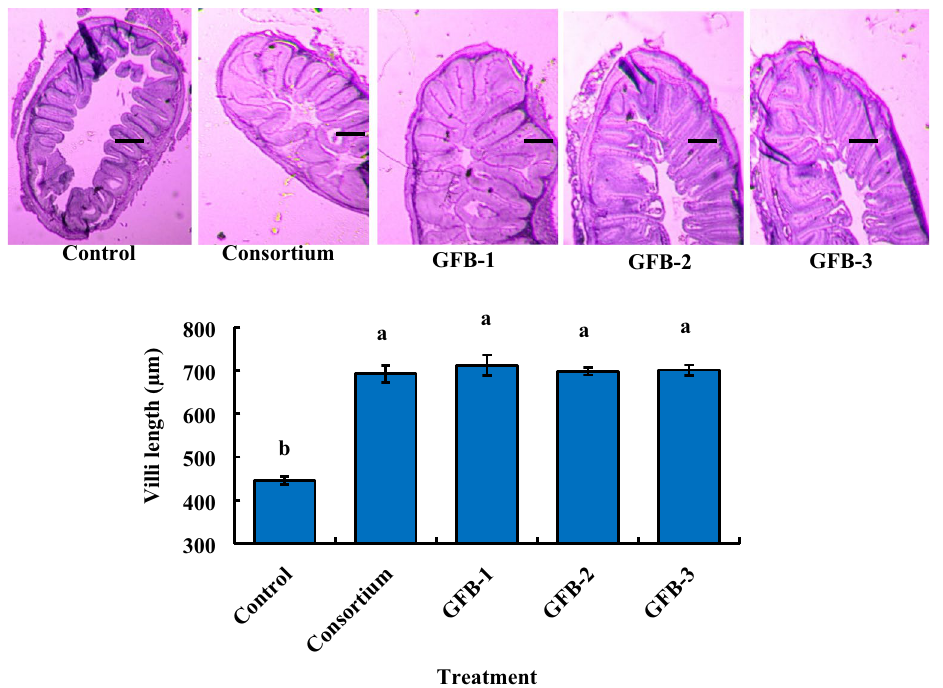
Figure 5. Histological analysis of the effects of probiotic bacteria supplementation on villi length of intestine of B. gonionotus (A-F). Fishes were fed on (A) control diet (0 CFU kg −1 feed), (B) consortium (T2) (1.35 × 10 9 CFU kg −1 feed), (C) GFB-1 (1.62 × 10 9 CFU kg −1 feed), (D) GFB-2 (1.43 × 10 9 CFU kg −1 feed) and (E) GFB-3 (1.06 × 10 9 CFU kg −1 feed). (F) It shows probiotic bacteria treated intestinal villi length compared to control (n = 6). Different letter bars indicate significant variations in intestinal villi length of fishes (F) fishes in different groups by the isolates at P < 0.05 (Statistix 10). Scale bar = 100 µm; image 4x; H & E 200. R 2 values are as follows: Control (0.737), Consortium (0.639), GFB-1 (0.946). GFB-2 (0.746), and GFB-3